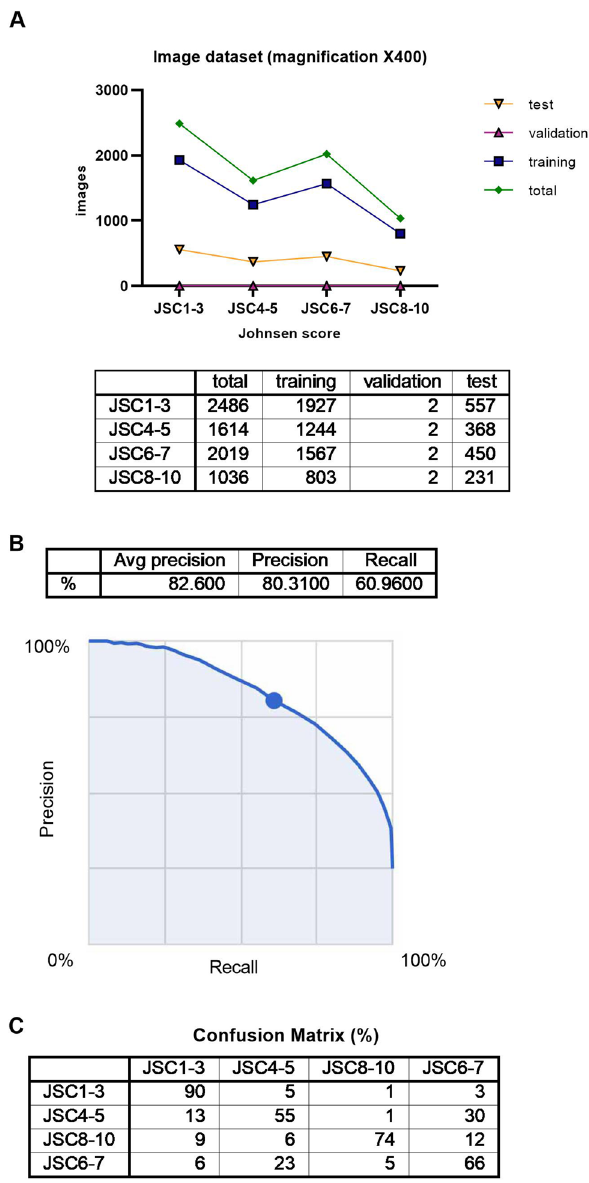
Figure 2. ( A ) Summary of image dataset (magnification ×400). ( B ) Algorithm performance using Google Cloud AutoML Vision, Average precision recall curve for image dataset, magnification ×400. ( C ) Confusion matrix for image dataset, magnification